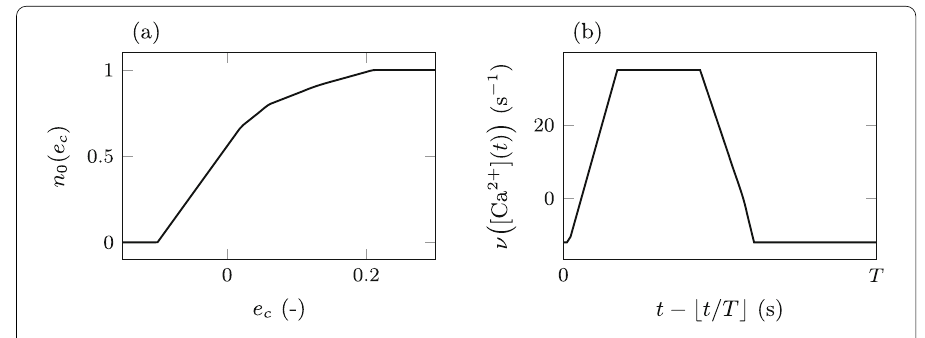
Fig. 1 a Definition of the function n 0 . b Time evolution of contraction triggering function ν . We denote here by T the duration of a